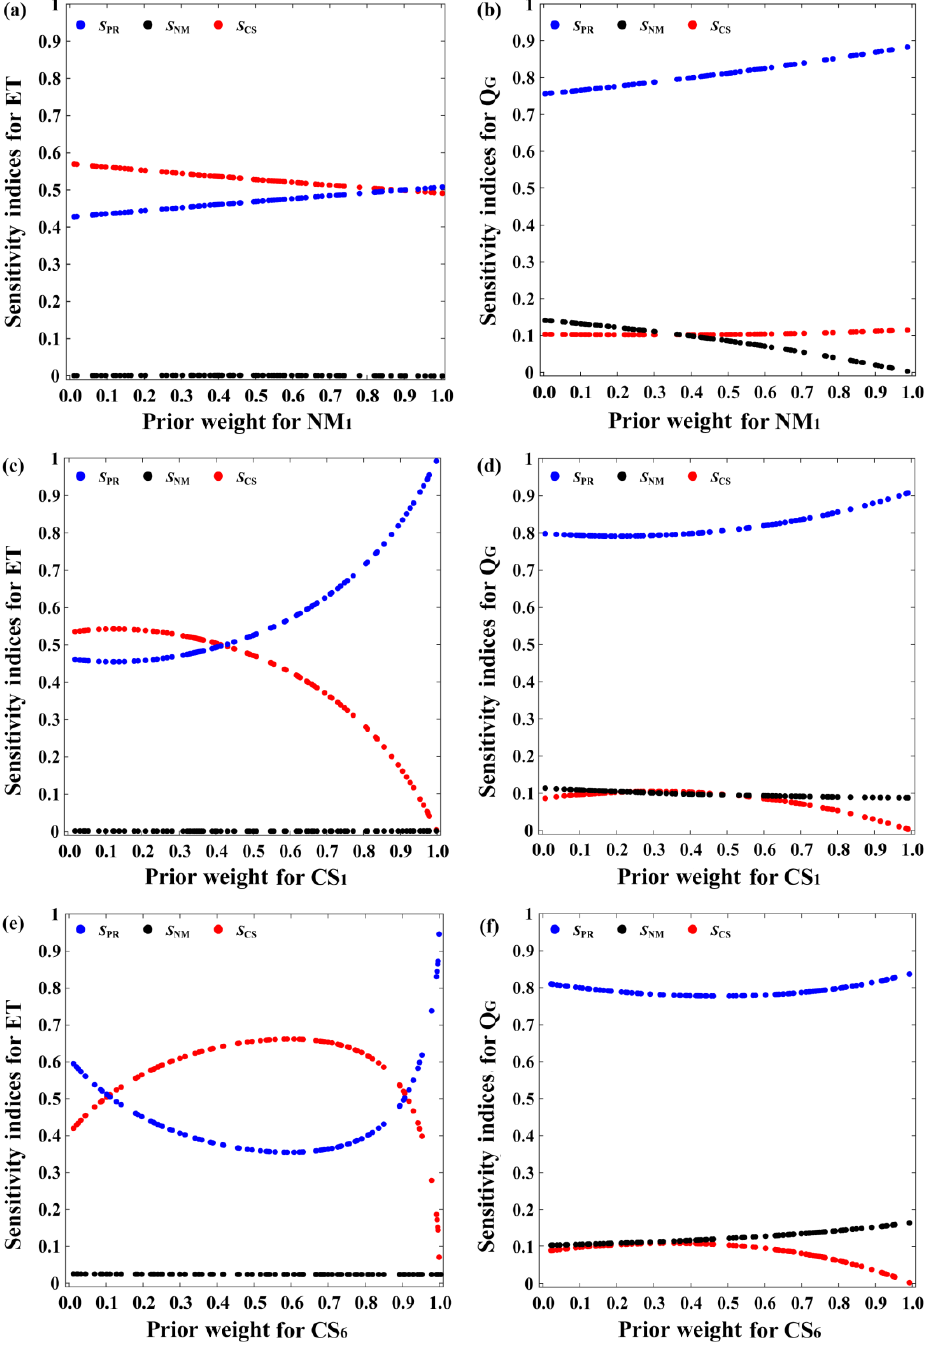
Figure 12. Patterns of S PR , S NM , and S CS for space-averaged evapotranspiration (ET) and space-averaged groundwater contribution to stream flow ( Q G ) with changes in the prior weights of numerical model NM 1 , climate scenario CS 1 , and climate scenario CS 6 at the time step of 4308h (at